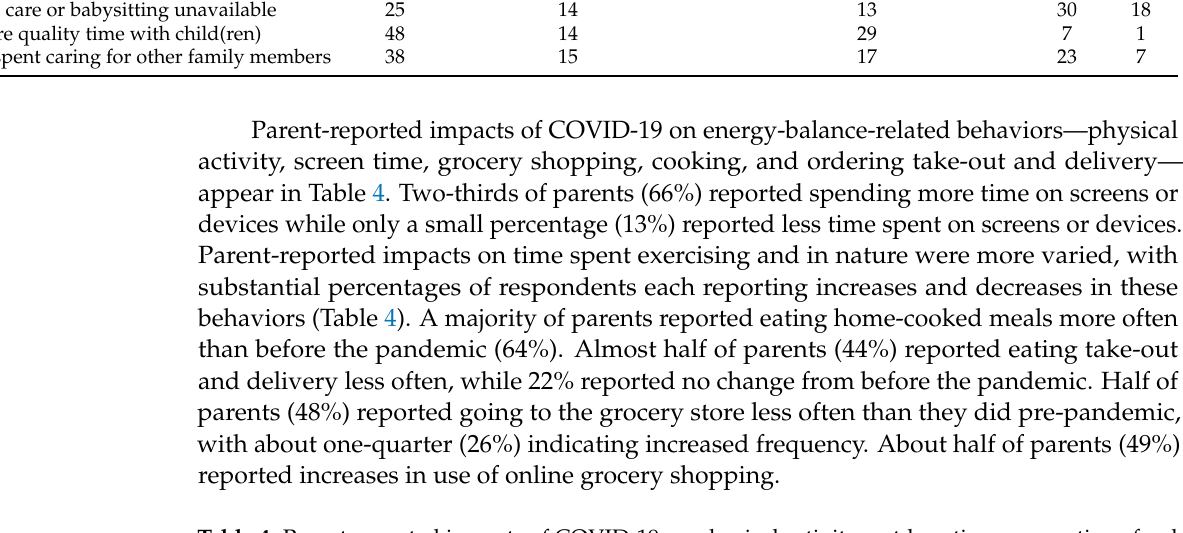
Table 4. Parent-reported impacts of COVID-19 on physical activity, outdoor time, screen time, food acquisition, and cooking ( n =